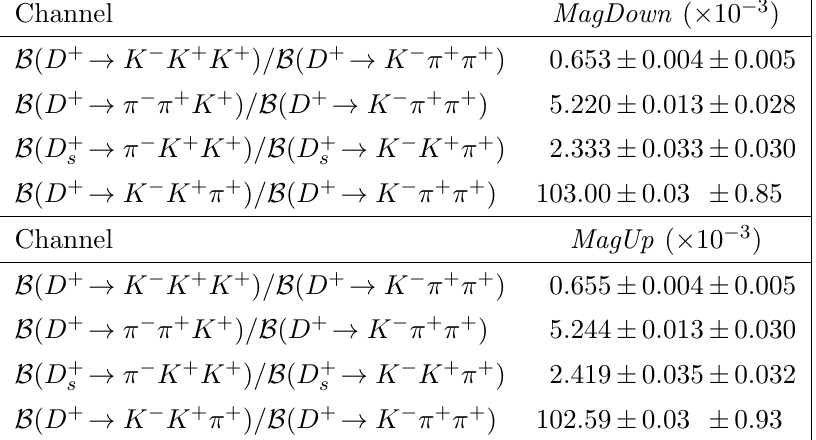
Table 6 . Ratios of branching fractions, shown separately for MagDown and MagUp samples. The (cid:12)rst uncertainty is statistical and the second is